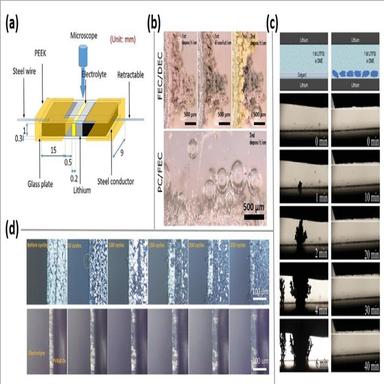
(a) Configuration of a custom-built testing cell for in-situ Li-dendrite probing (Reproduced with permission from ref. Copyright 2018 Wiley–VCH); (b) optical patterns of sodium electrodeposition and gas generation during the first charge/discharge in several electrolytes (Reproduced with permission from ref. Copyright 2017 American Chemical Society); (c) the growth of lithium dendrites on bare Li metal (left) and on the OPTM@Li (right) (the width of the images was about 3 mm) (Re